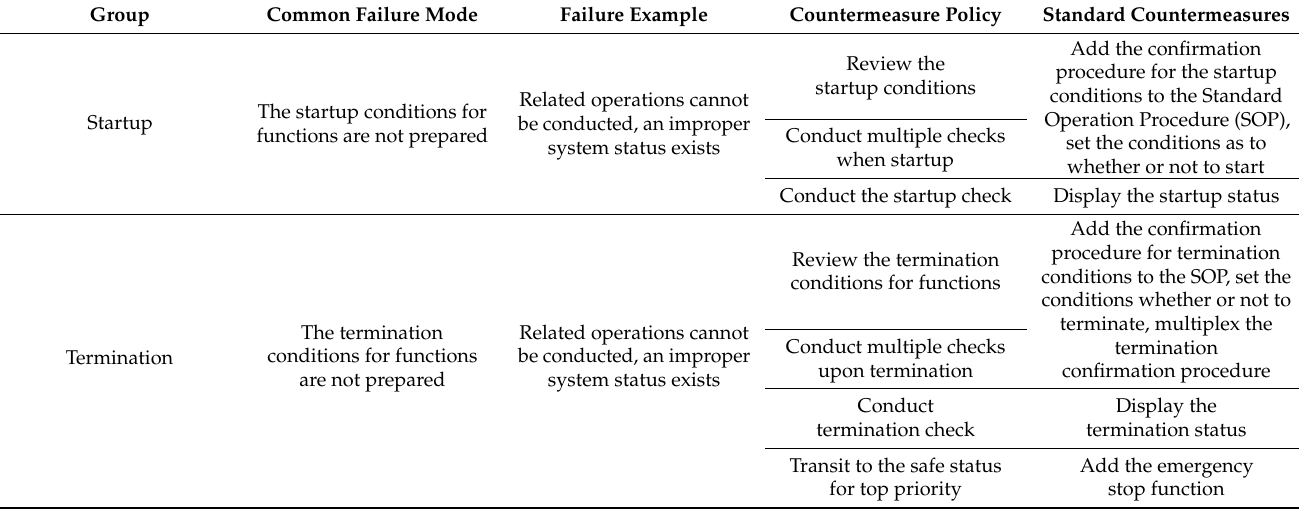
Table 1. Common failure modes and standard